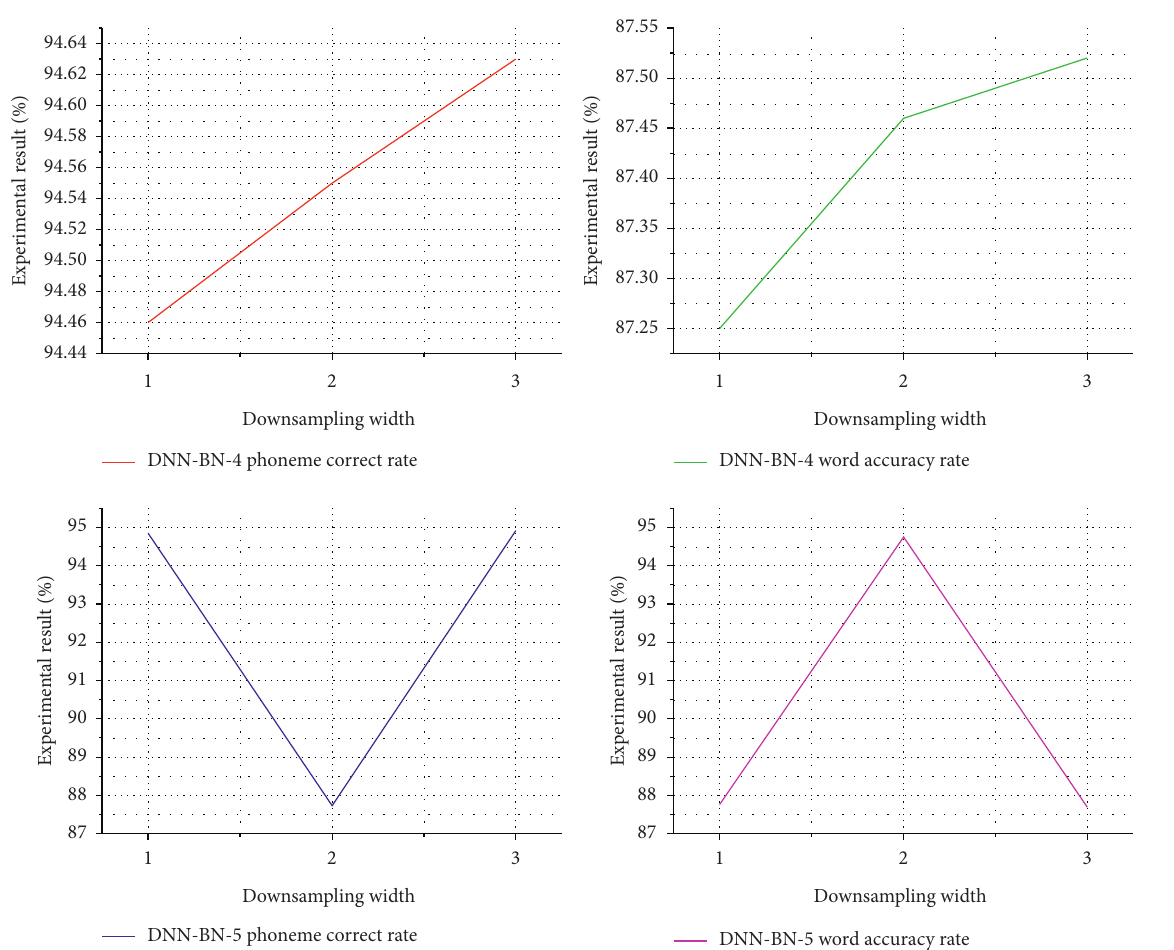
Figure 7: Performance comparison of